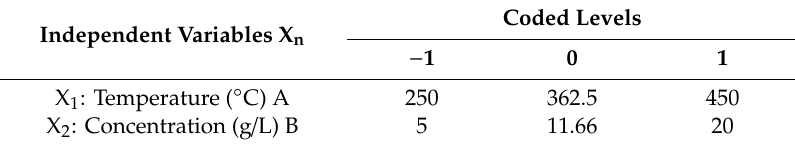
Table 2. Experimental design variables used for modeling the absorbance of treated lube